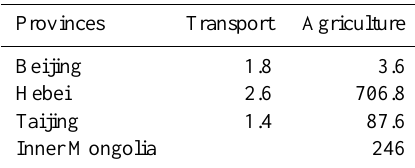
Table 2. NH 3 emission estimates (KtNH 3 -Nyr − 1 ) in Beijing and surrounding areas in